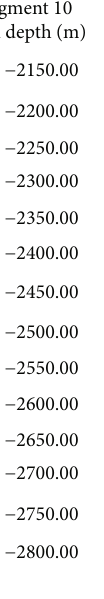
Figure 12: 3D structural model of the study area.